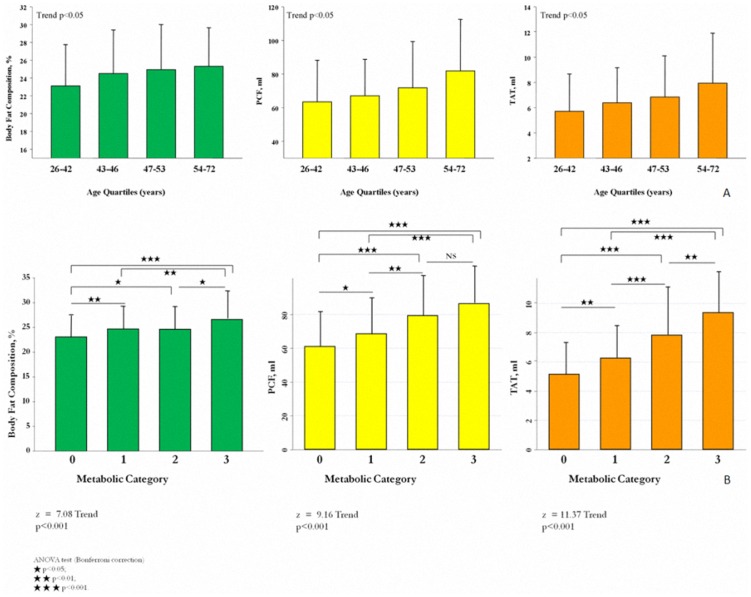
Comparison of body fat composition, pericardial and thoracic peri-aortic adipose tissue with age quartiles and numbers of abnormal metabolic components. A) Increases in adiposity across age quartiles in our cohort (all p for trend <0.05). B). Larger numbers of abnormal metabolic components were associated with higher body fat composition and increasing visceral adipose tissue burden (all p for trend <0.001). Metabolic category 0, metabolic score = 0; 1, metabolic score = 1; 2, metabolic score = 2; 3, metabolic score ≥3. Abbreviations as in Figure 1. ★p<0.05, ★★p<0.01, ★★★p<0.001 by ANOVA post hoc paired comparison